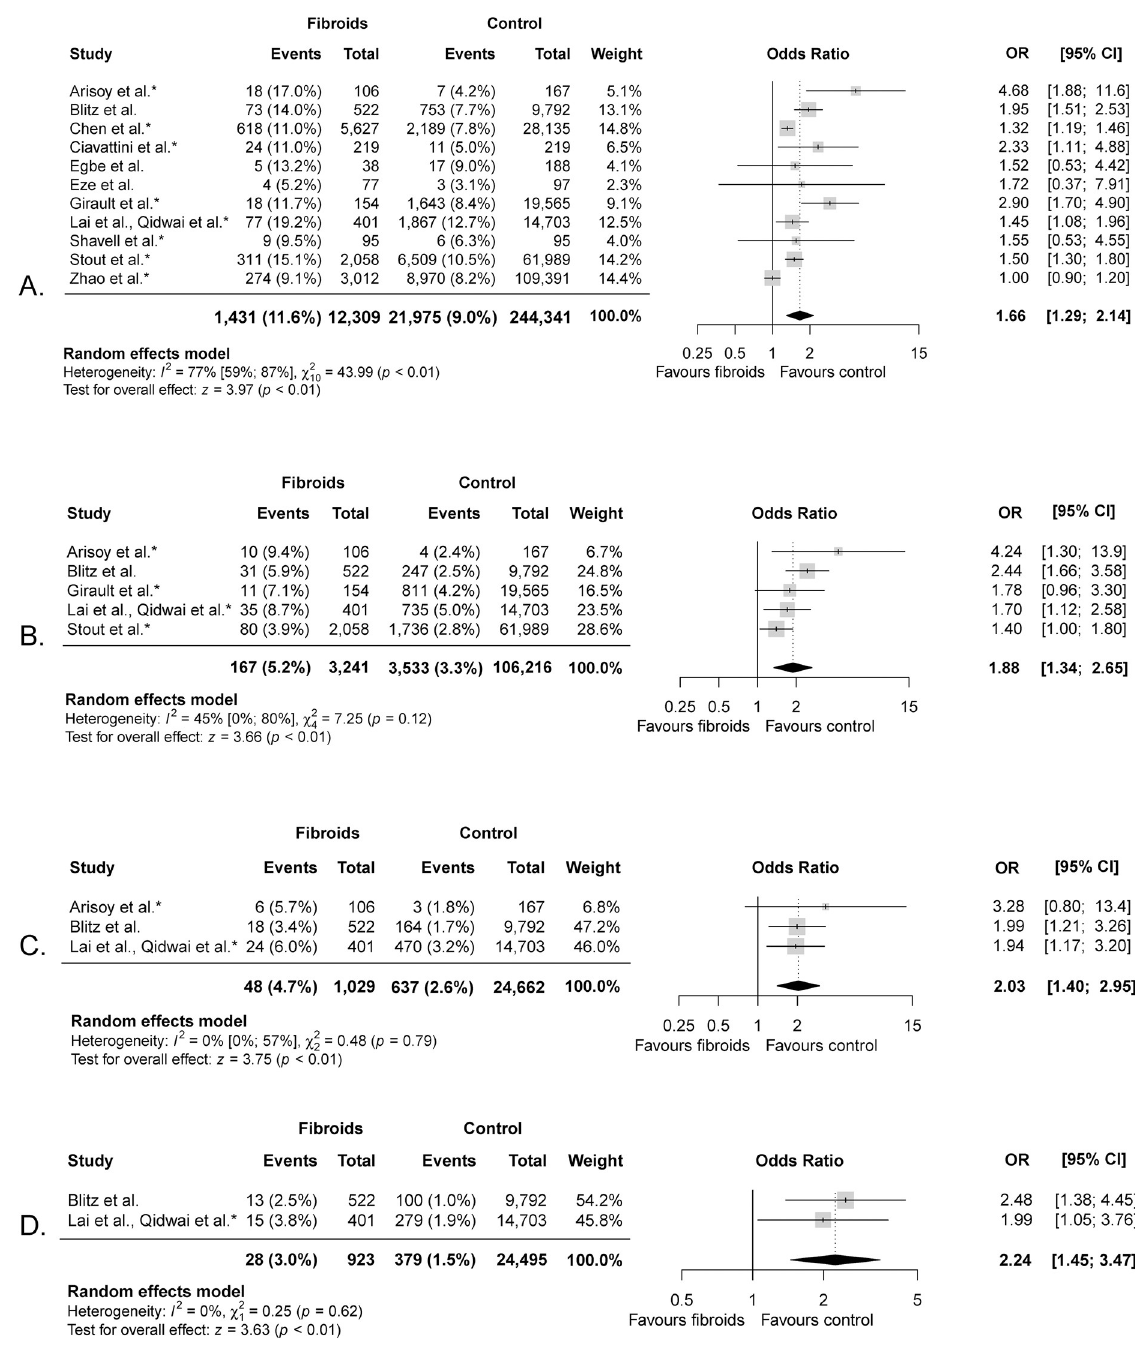
Fig 2. Meta-analysis of preterm birth < 37 (A.), < 34 (B.), < 32 (C.) and < 28 (D.) weeks of gestation in women with fibroids. � indicates studies that corrected for potential confounders. quality study assessing these outcomes. There was no significant association between fibroids and PPROM in a sensitivity analysis (11.3% versus 10.5%; OR 1.97, 95% CI 0.84–4.61). Girault et al. was rated as good quality but was not included in sensitivity analyses for preterm birth < 34 weeks of gestation and PPROM [16]. They provided additional preterm birth rates in